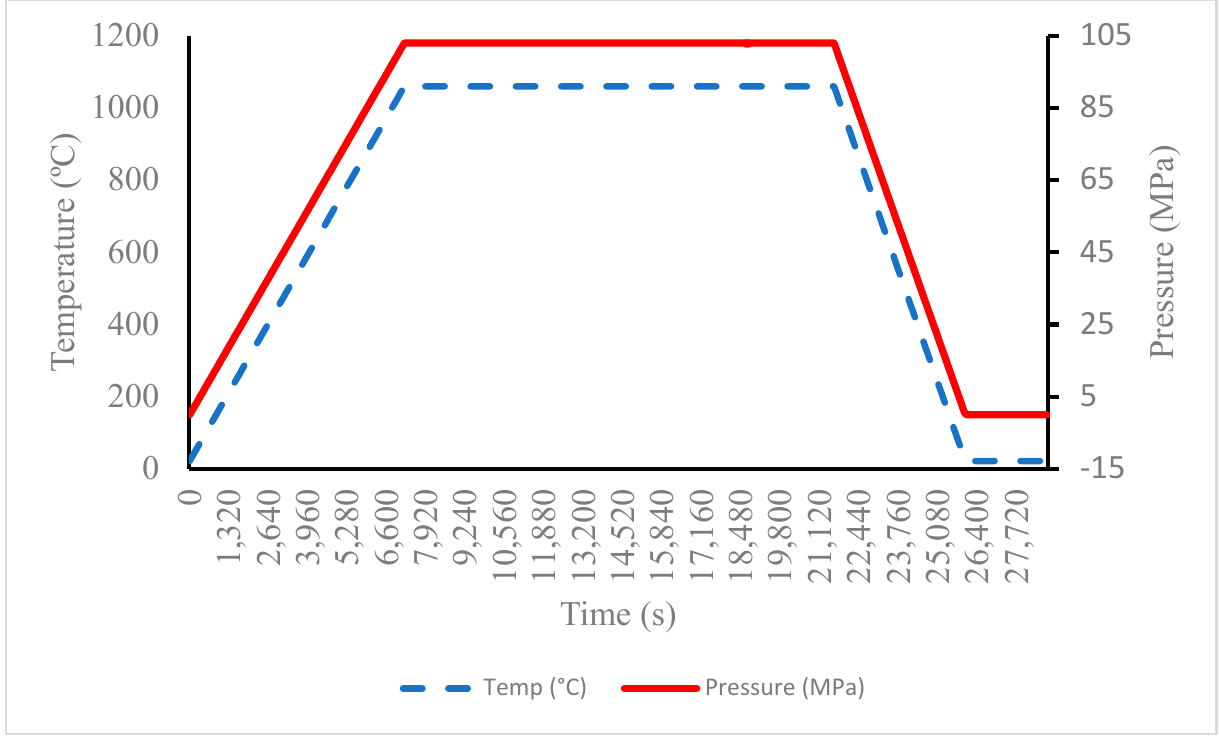
Figure 7. HIP temperature and pressure profiles.